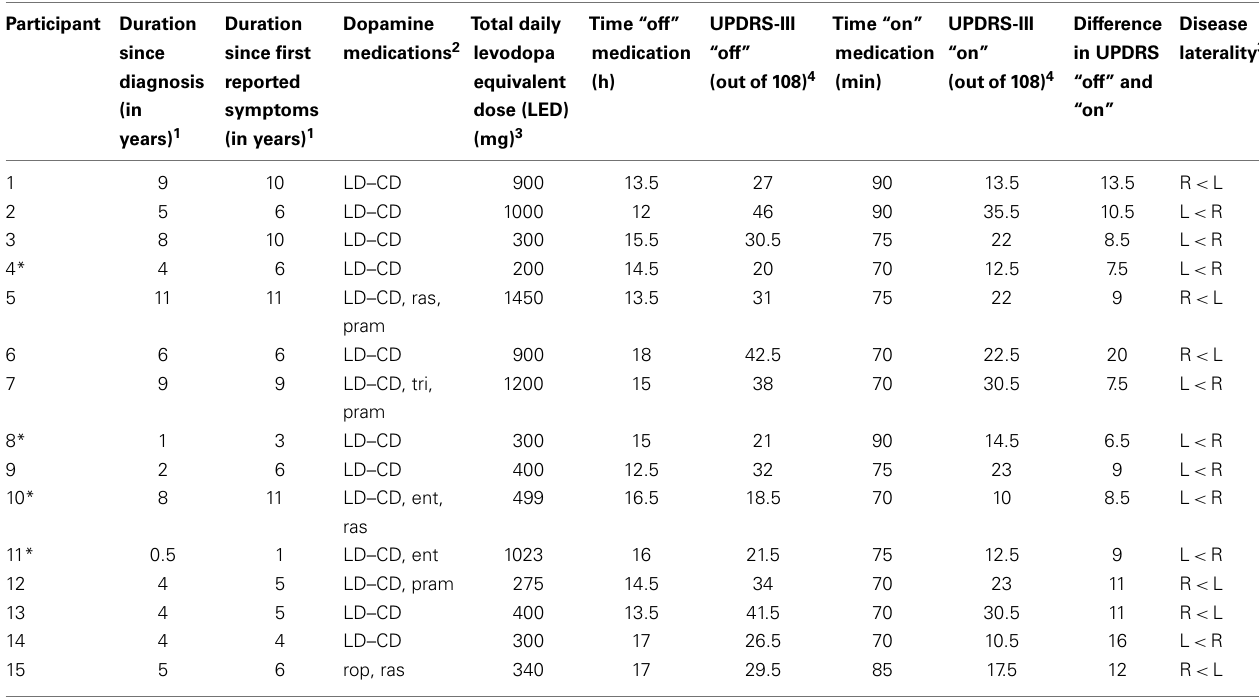
Table 2 | Clinical characteristics of PD